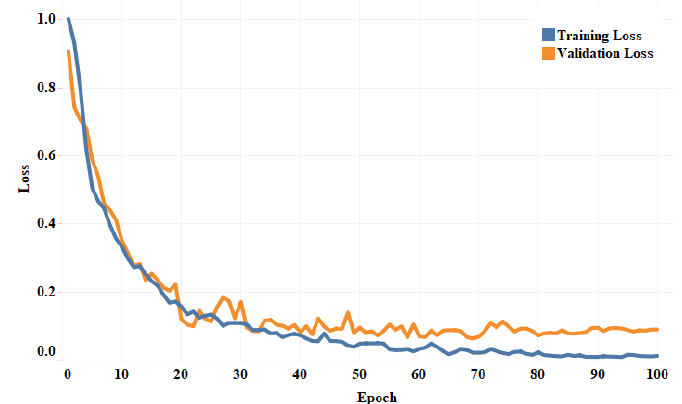
Figure 7. Illustration of the loss convergence plot for the first run of 10-fold CV.